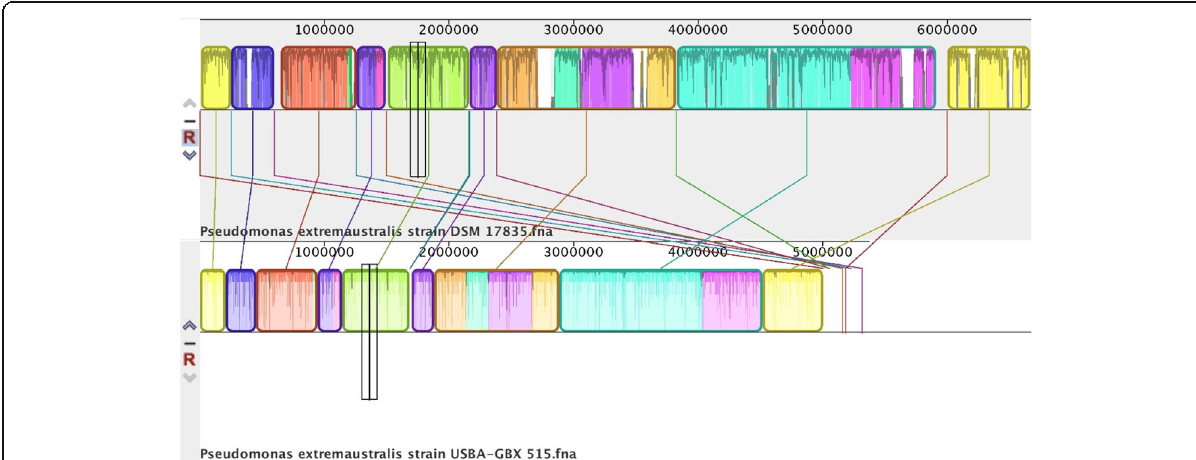
Fig. 3 Multiple Alignment performed using Mauve [42] of P. extremaustralis genomes. The type strain CT14 – 3 T of Pseudomonas extremaustralis (17835 T ) is shown in the top and the strain USBA-GBX 515 described here at the botton. Conserved blocks are represented with direct lines from type strain to our strain showing synteny of genes among the genome. Small regions between conserved blocks from type strain are